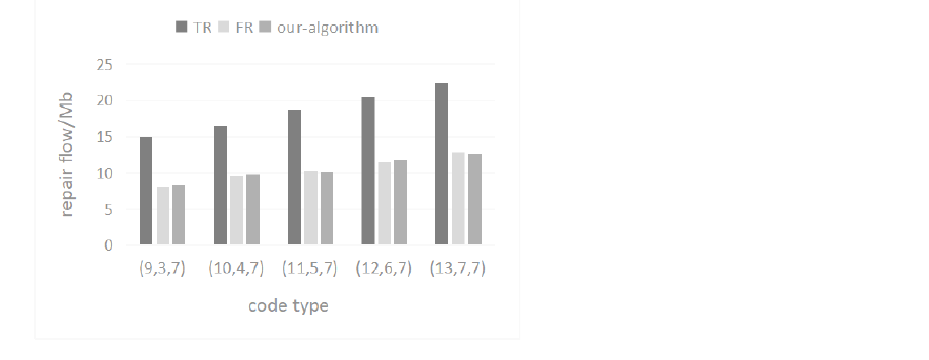
Figure 13. Topology repair traffic distribution diagram constructed by TR, FR, and our algorithm under different erasure code sizes.